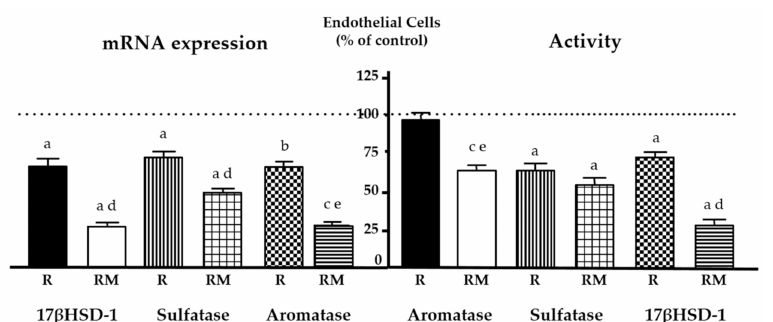
Figure 2. Effects of melatonin on radiation-induced changes on proteins involved in estrogen biosynthesis. Melatonin pretreatment (1 mM) before radiation (RM) increased the inhibitory effect induced by radiation (R) on aromatase, sulfatase, and 17 β HSD-1 (17 β hydroxysteroid dehydrogenase type 1) activity and expression on HUVEC endothelial cells. Data are expressed as the percentage of the control non-radiated group (mean ± SEM). (a), p < 0.001 vs. control non-radiated cells; (b), p < 0.01 vs. control non-radiated cells; (c), p < 0.05 vs. control non-radiated cells; (d), p < 0.001 vs. radiated cells; (e), p < 0.05 vs. radiated cells. Modified from Gonz á lez-Gonz á lez et al.